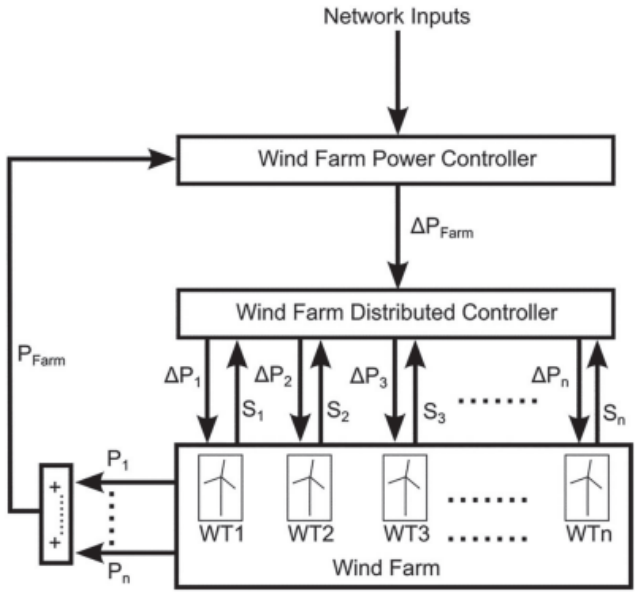
Figure 6. The generic form of the wind farm control architecture as shown in